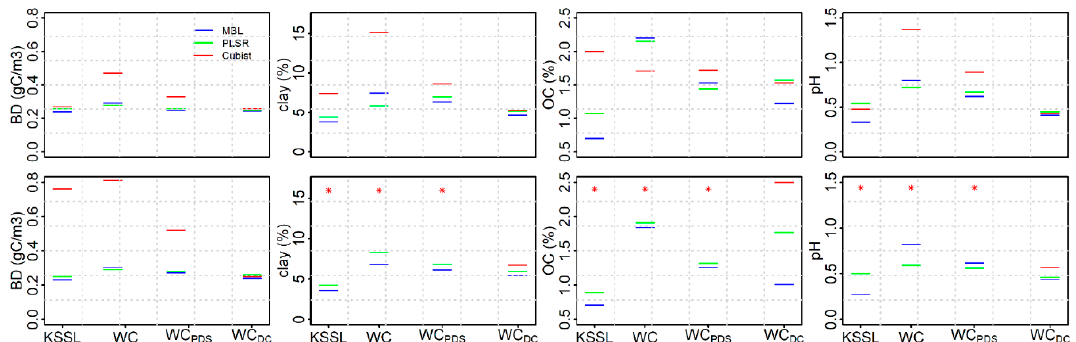
Figure 3. Root mean square error (RMSE) of KSSL, Woodwell (WC), Woodwell PDS (WC PDS ) and Woodwell DC (WC DC ) spectra representing independent validation set of the US origin (set II) for all three modeling approaches (MBL, PLSR and Cubist). The top and bottom panel shows the RMSE estimated using the prediction from the baseline corrected and first derivative spectra, respectively. The Woodwell DC (WC DC ) are the Woodwell (WC) spectra predicted using the direct calibration and leave-one-out cross validation. The red asterisk symbol shows that the RMSE using Cubist are too high to be included within the y -axis range for the given soil property.